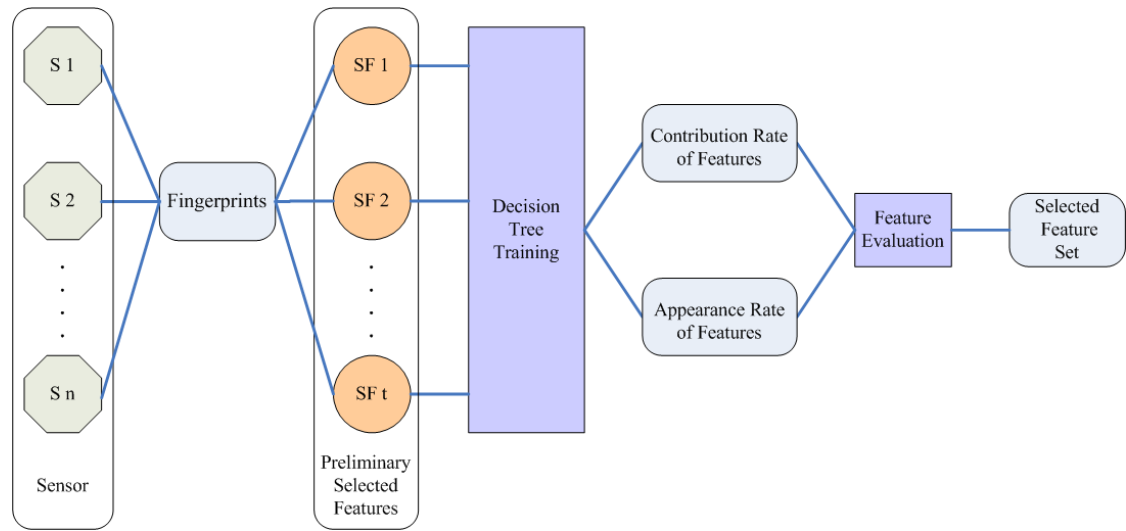
Figure 5. Framework of the second level